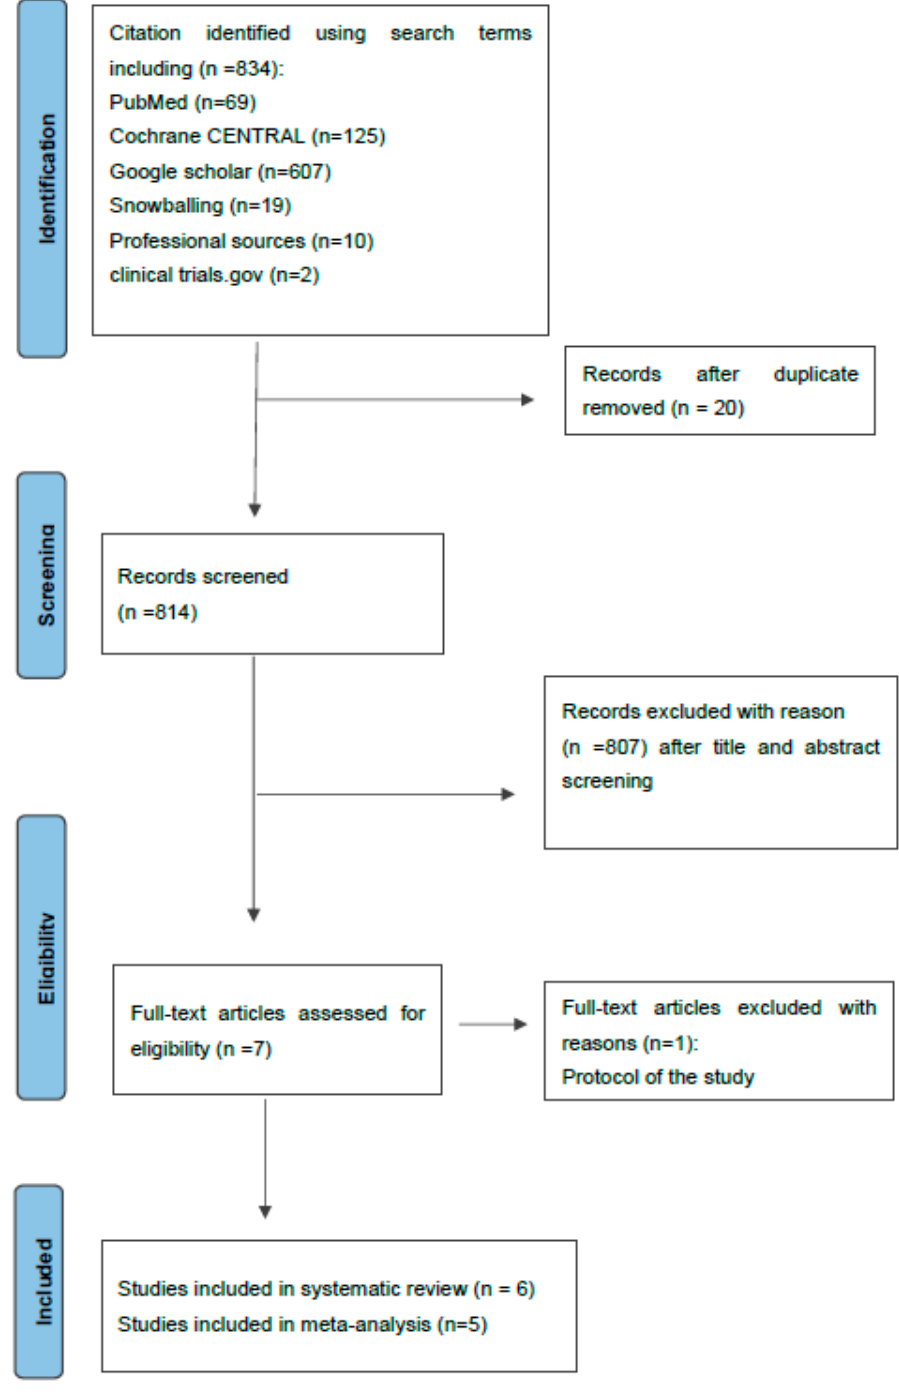
Figure 1. Flow chart of identification of studies included.